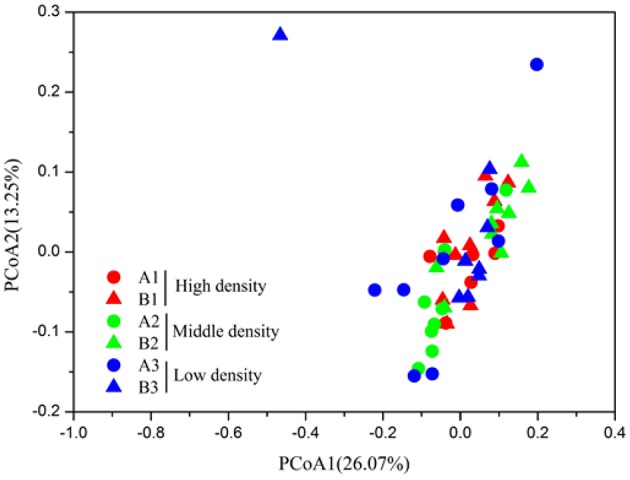
The Principal coordinate analysis of pika gut microbiota of high-density groups (A1 and B1), middle-density groups (A2 and B2), and low-density groups (A3 and B3).